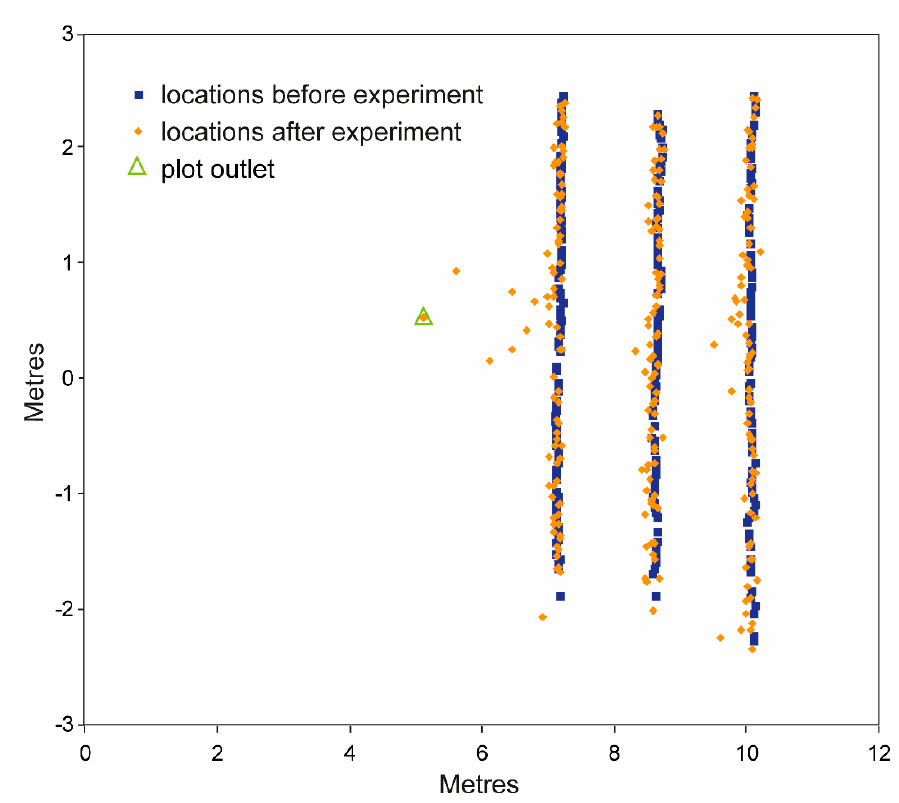
Figure 6. Locations of tagged particles before and after experiment 1. Particles leaving the plot are shown located at the plot outlet. Distances on the axes are x and y coordinates from the location of the total station used to record the locations.